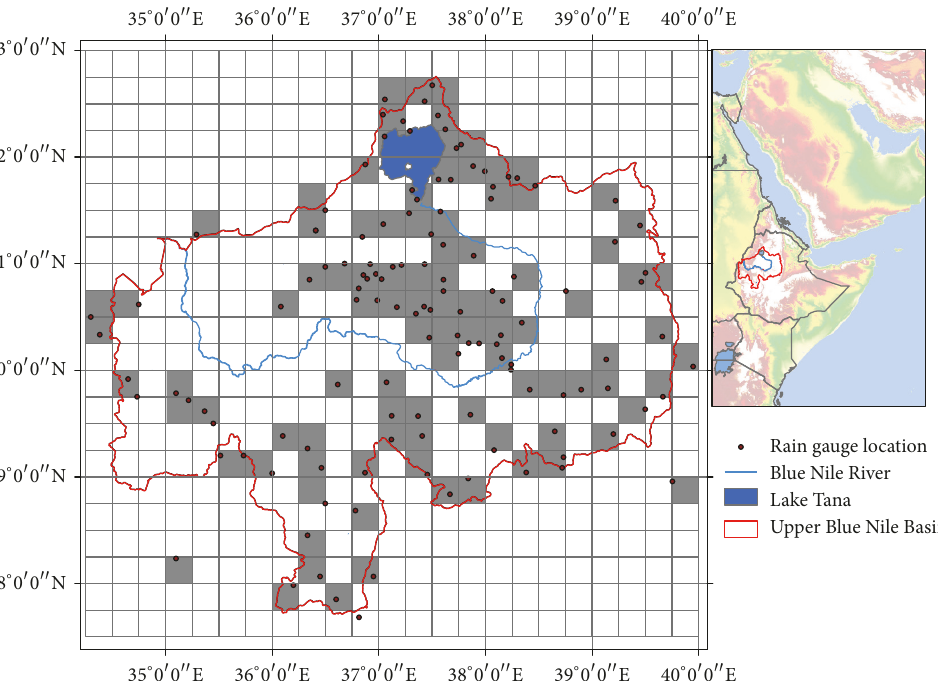
Figure 1: The Upper Blue Nile Basin in the Eastern Africa, overlaying the rain gauge network and the global precipitation estimates grid. In gray highlighted grid pixels, we depict those grid cells that include at least one